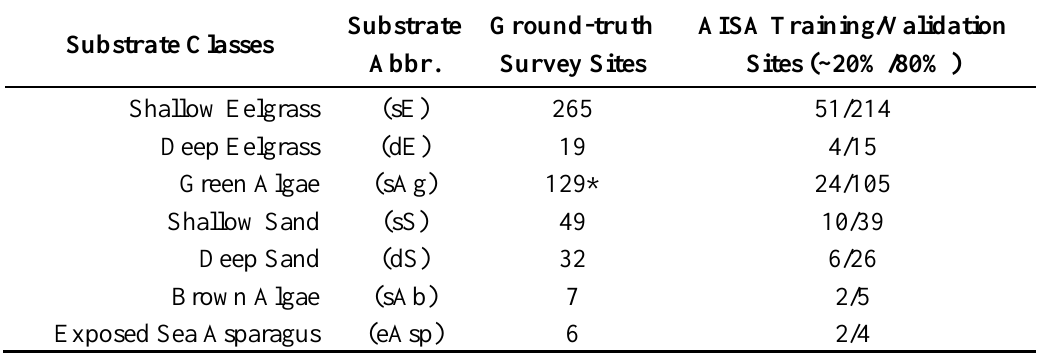
Table 4. Ground truth survey sites for each substrate and number of sites designated as training and validation ROIs for supervised